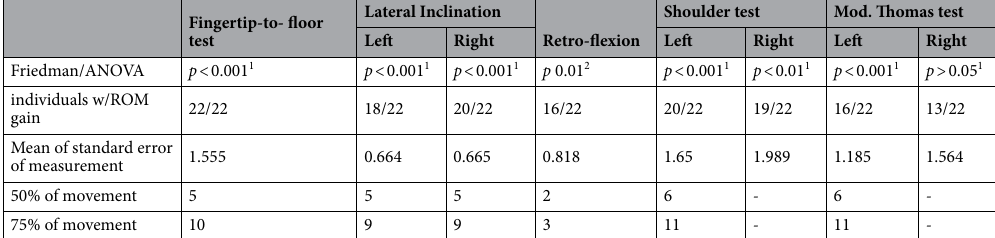
Table 1. P-values of Friedman test and ANOVA for each ROM test. Relative amount of individuals with an ROM gain, mean of the standard measurement error and number of repetitions needed to achieve 50% and 75% of the total ROM increase for each ROM test, respectively. ANOVA = 1 ; Friedman test =